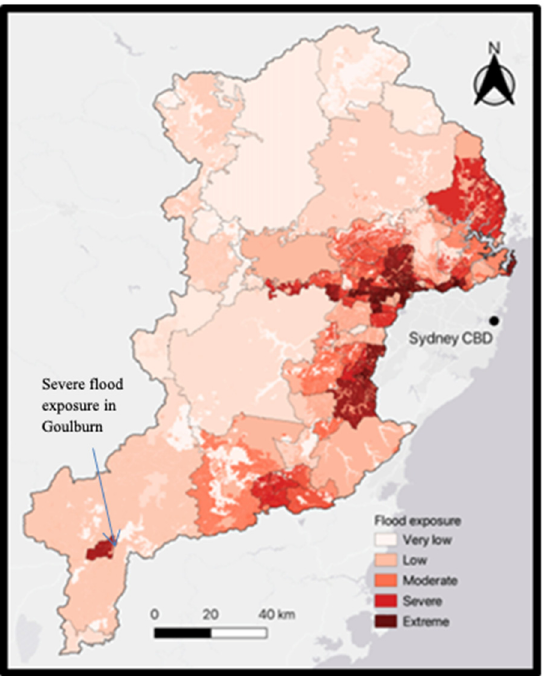
Figure 5. Map of the FEI in the HNC (at 50 m resolution) based on population density, land use type, and critical infrastructure density inputs (QGIS